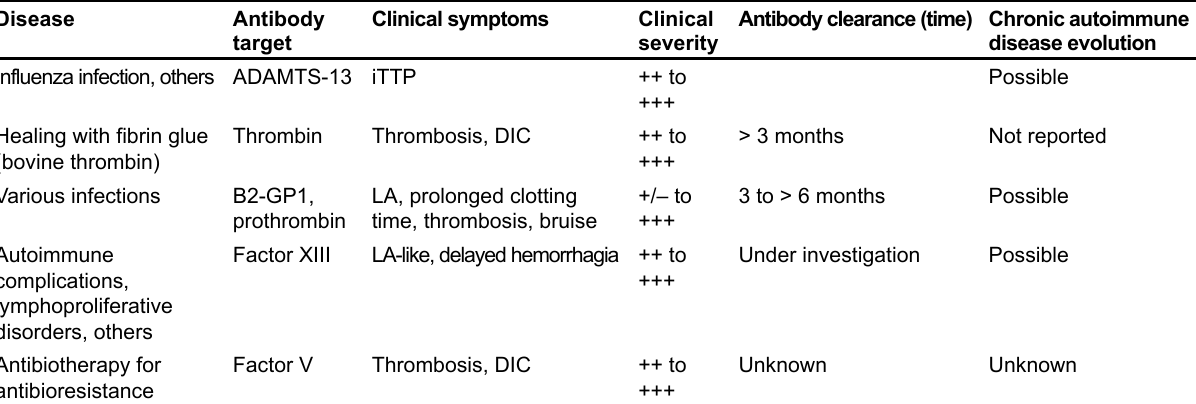
Table 1. Examples of autoantibody generation in situations where an infectious component or a drug bind to a blood protein ( continued ) Disease Antibody target Influenza infection, others ADAMTS-13 iTTP ++ to